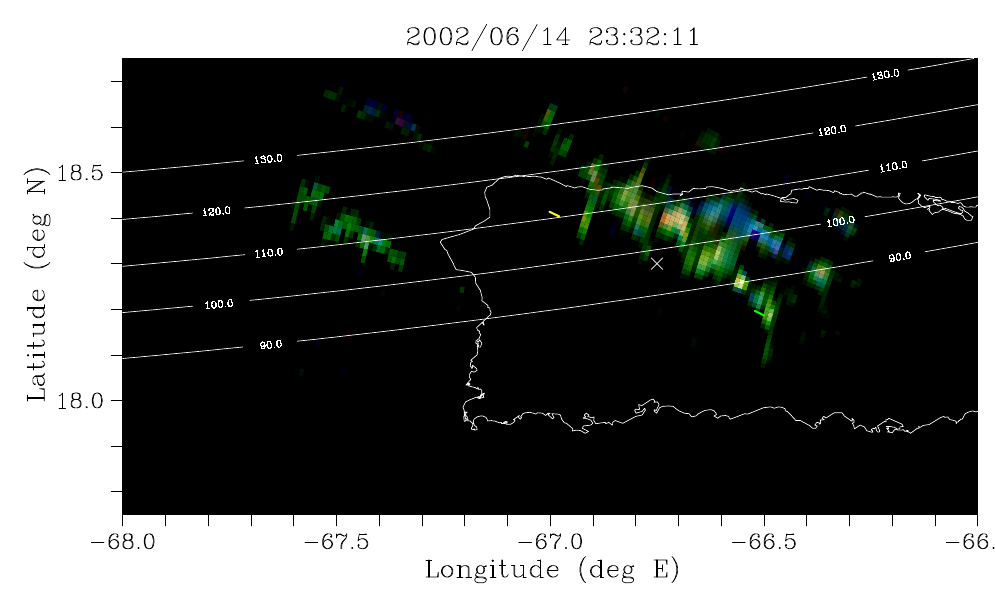
Fig. 9. Radar image of coherent echoes received at 23:32UT. Note that